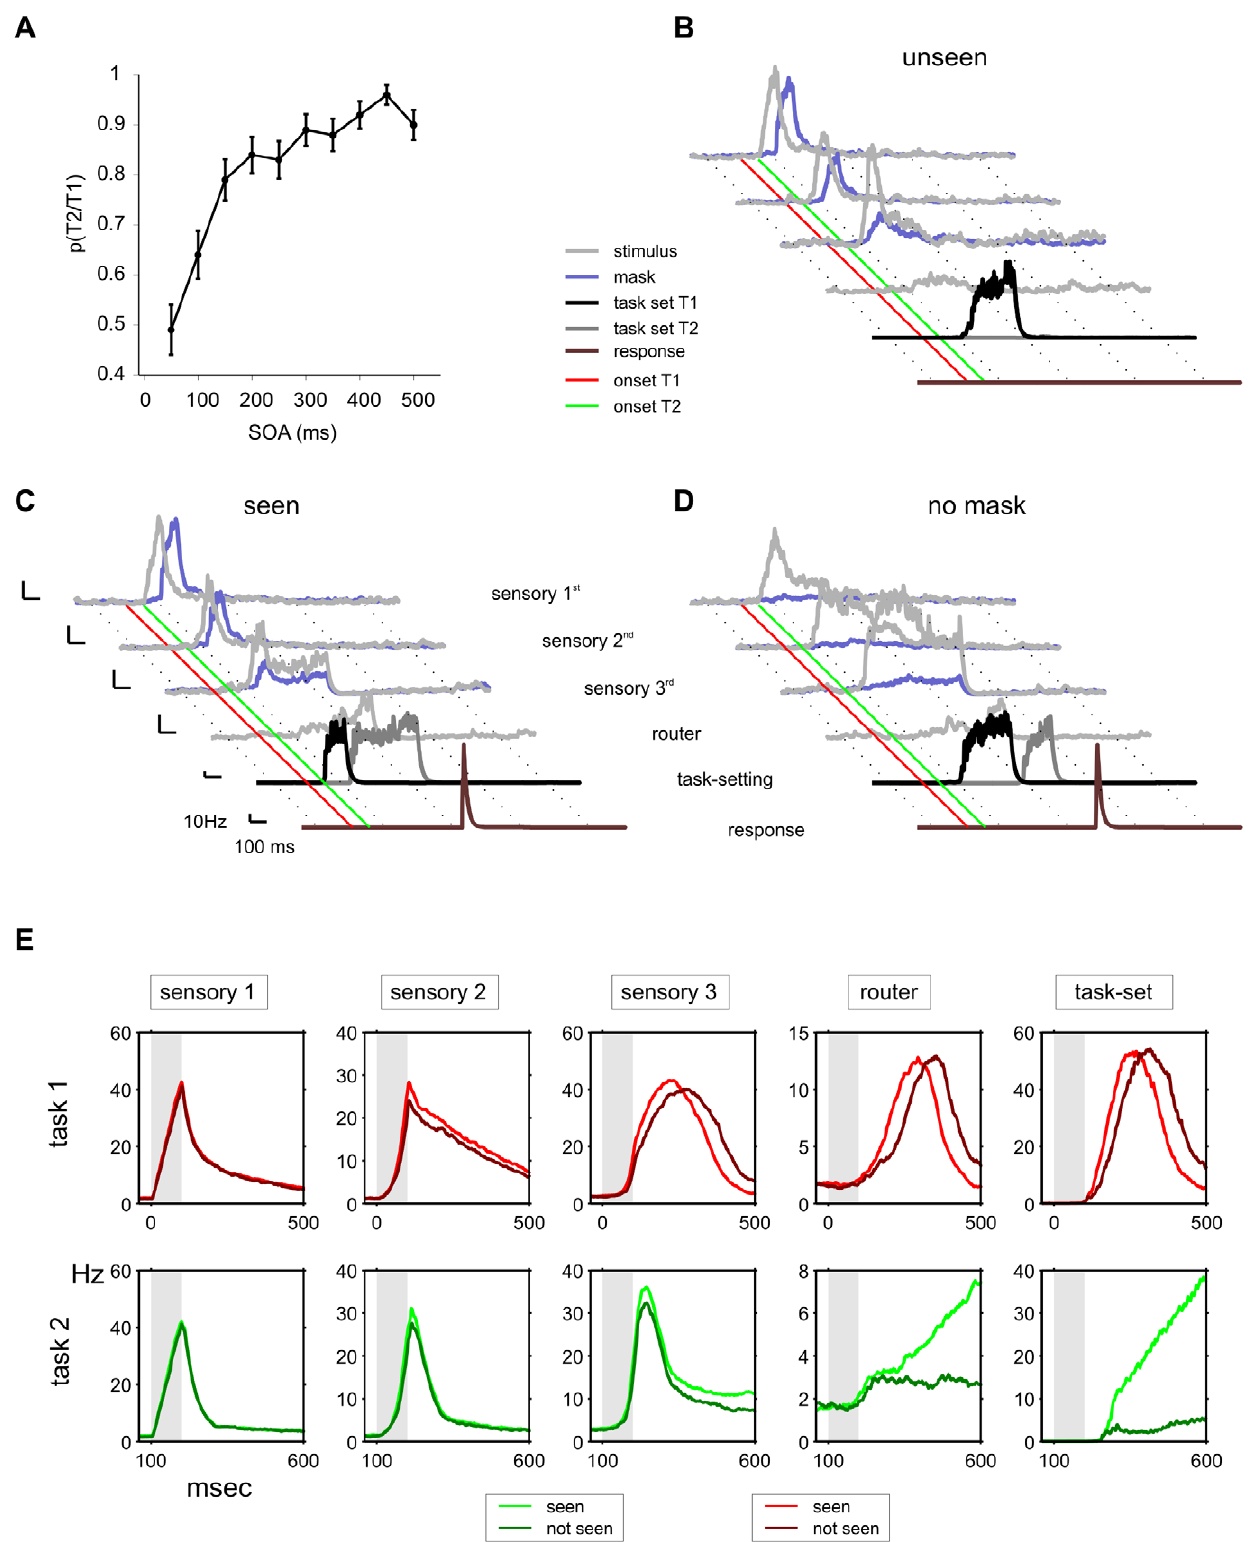
Figure 7. From the PRP to the attentional blink: masking effects on visibility. When T2 is masked the model displays characteristic aspects of AB experiments. (A) Probability of responding correctly to T2 given T1 correct, for varying SOA (error bars depict the standard error of the mean). (B–D) Single-trial population firing rates of relevant populations for trials with seen and unseen T2. The average response of neurons selective to T2 (grey traces) and to the mask (purple traces) is shown at different sensory levels. The average activity of task-setting excitatory neurons selective to T1 is plotted in black, and motor neurons for the correct response to T2 are plotted in brown. The red line indicates the onset of T1, and the green line